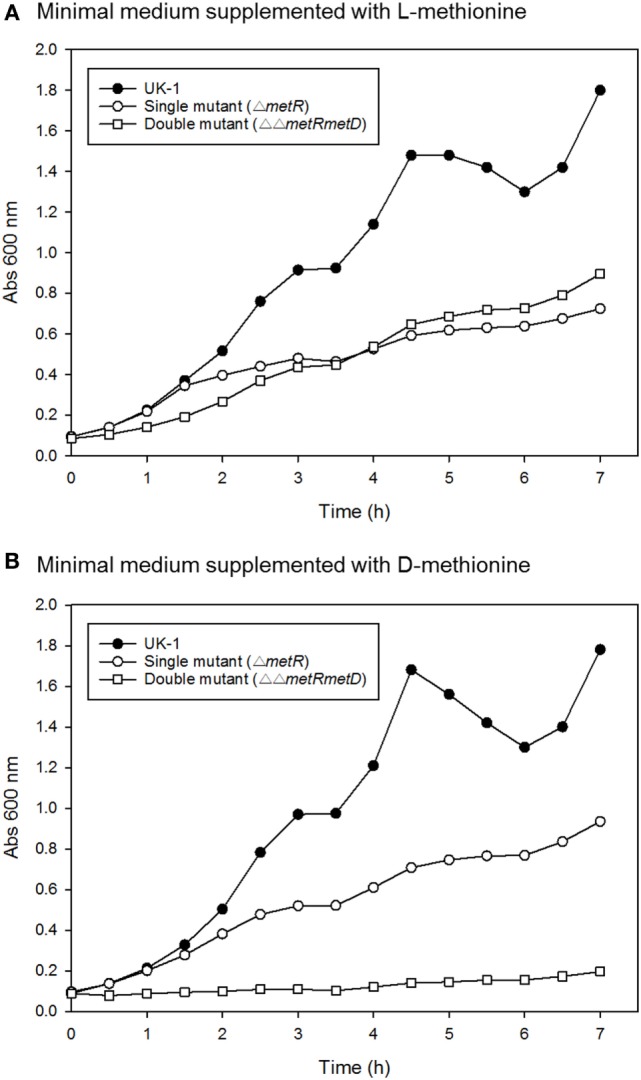
Growth curves of S. Typhimurium wild-type (UK-1), single (ΔmetR), and double mutant (ΔΔmetRmetD) mutant in minimal medium supplemented with (A) L-methionine or (B) D-methionine.